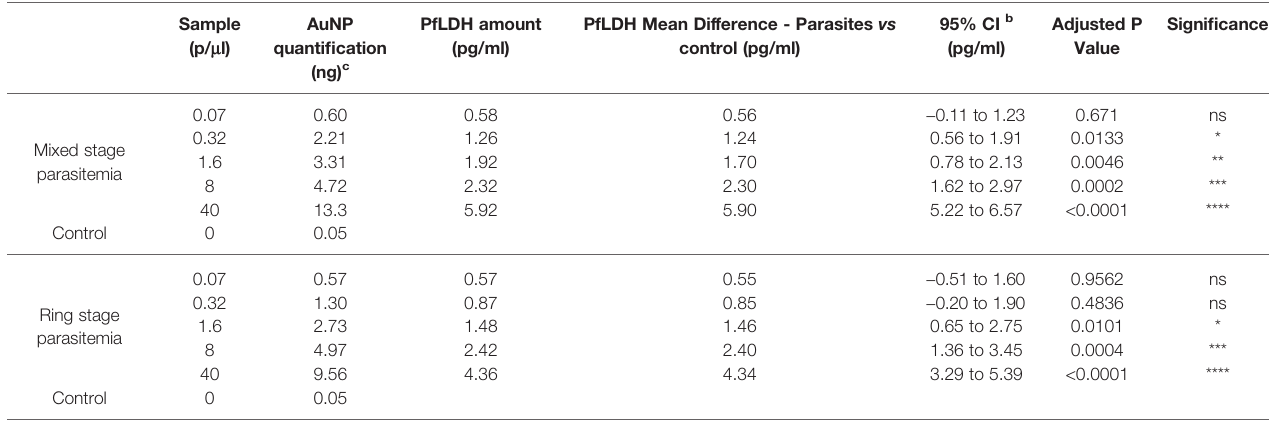
TABLE 1 | AuNP quanti fi cations of parasite-infected relative to control erythrocyte samples by ICP-MS immunoassays. a